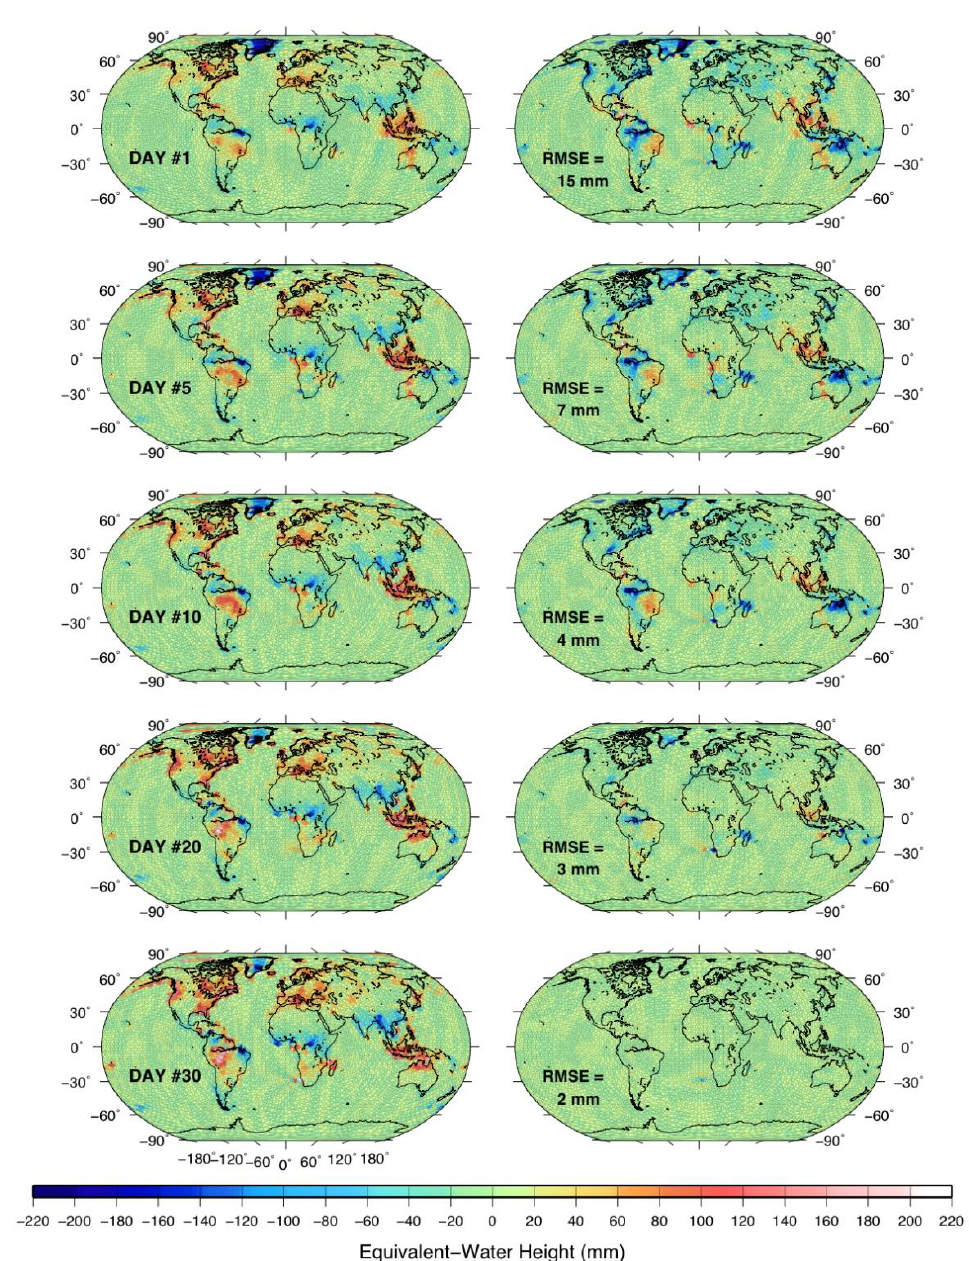
Figure 1. Snapshots of daily global estimations of water mass density from WGHM-simulated potential anomalies that decrease with the number of iterations ( left column ), and associated absolute errors ( right column ).